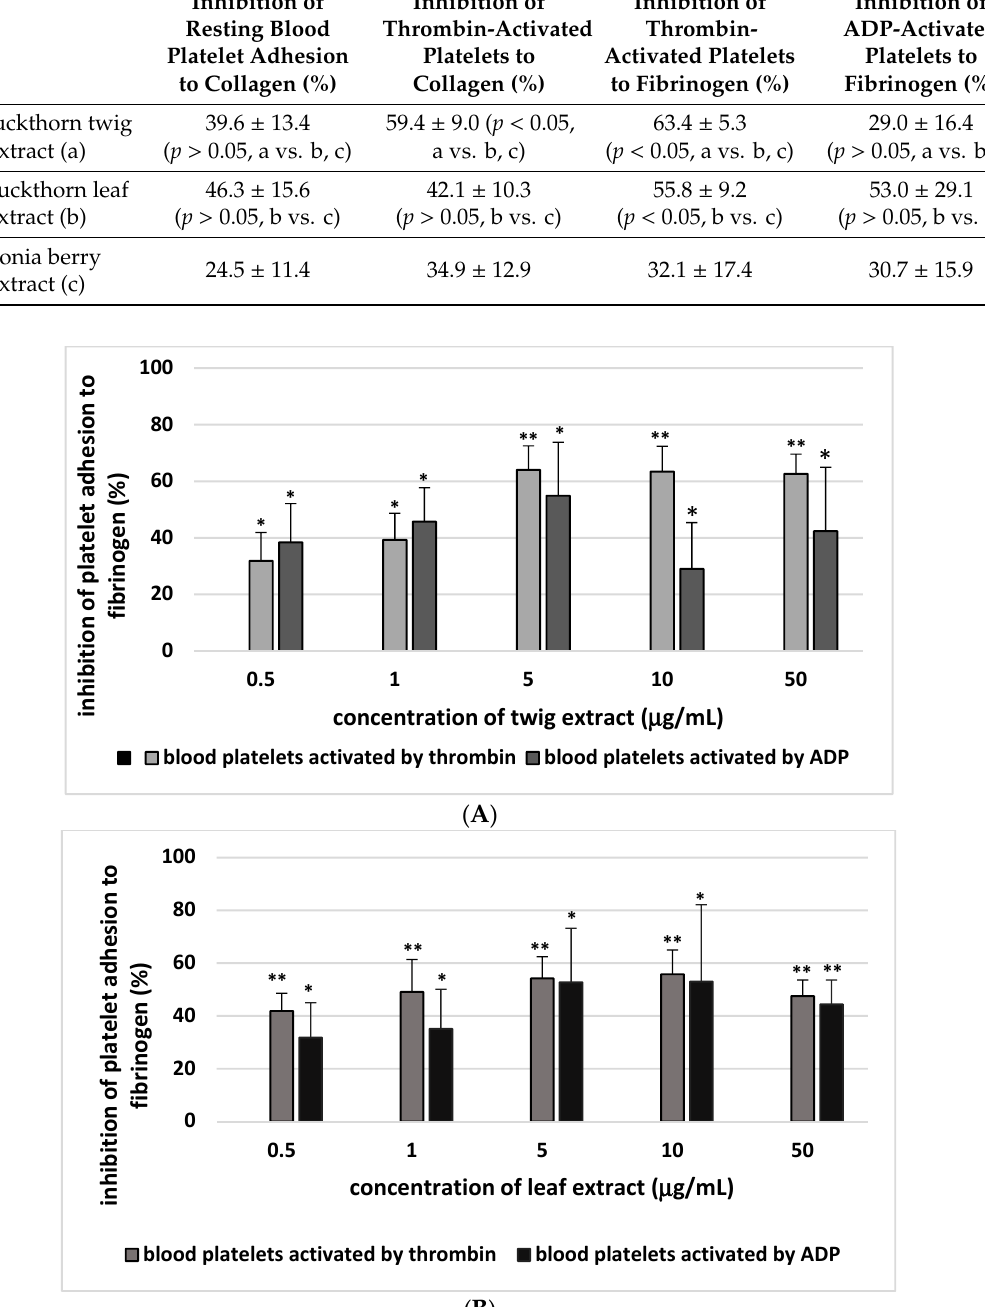
Figure 2. Twig (A) and leaf extract (B) (0.5–50 µg/mL; 30 min) on adhesion of thrombin/adenosine diphosphate (ADP)-activated platelets to fibrinogen. Inhibition of platelet adhesion by the plant extract is expressed as the percentage of that recorded for control blood platelets (without the plant extract) – positive control. Data represent mean ± SE of 5 (for ADP-activated platelets) and (for thrombin-activated platelets) healthy volunteers (each experiment performed in triplicate). * p < 0.05, ** p < 0.02 (vs. control platelets). Table 1. Comparison of the effects of sea buckthorn twig and leaf extracts and aronia berry extract at the concentration (10 µg/mL) on blood platelet adhesion. Results are given as means ± SE of 5–9 healthy volunteers (experiments done in triplicate).and expressed in percentage (%) difference between the control and tested extracts.